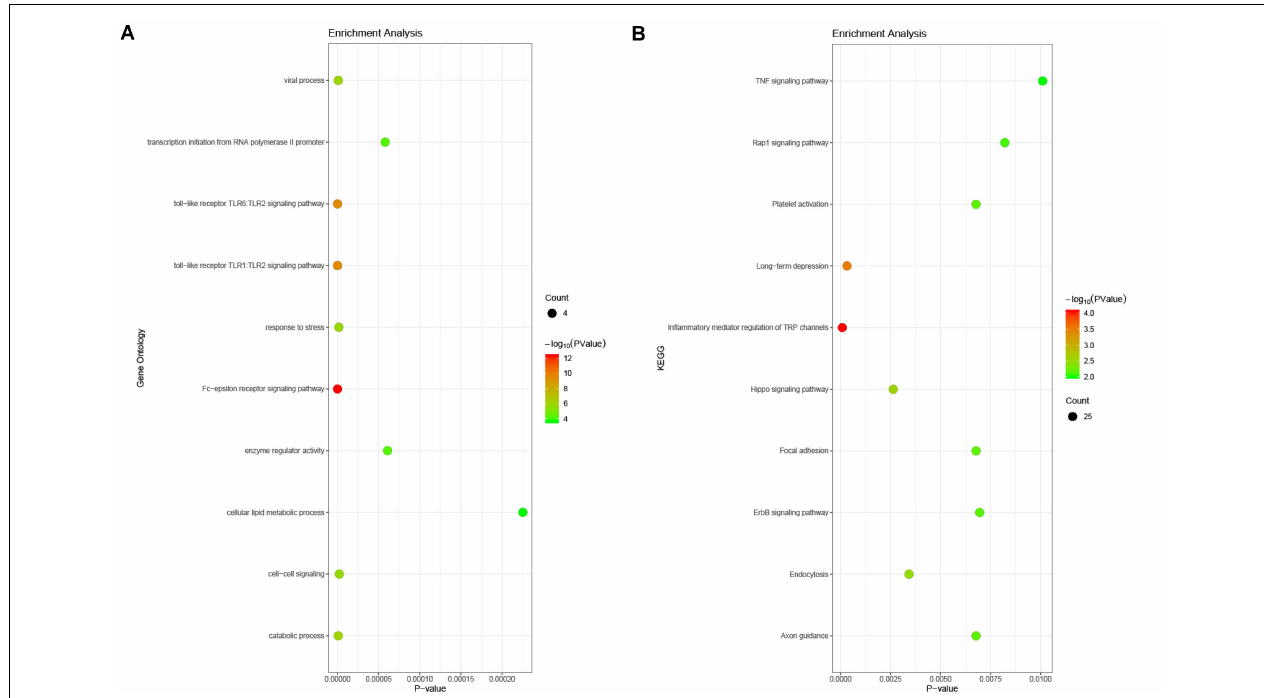
FIGURE 9 | Enrichment analysis of the microRNAs related to hub genes. (A) Gene ontology analysis. The microRNAs related to hub genes were abundant in the toll-like receptor TLR1:TLR2 signaling pathway, viral processes, and the Fc-epsilon receptor signaling pathway. (B) KEGG enrichment analysis. These miRNAs were mainly enriched in the TNF signaling pathway, focal adhesion, and platelet